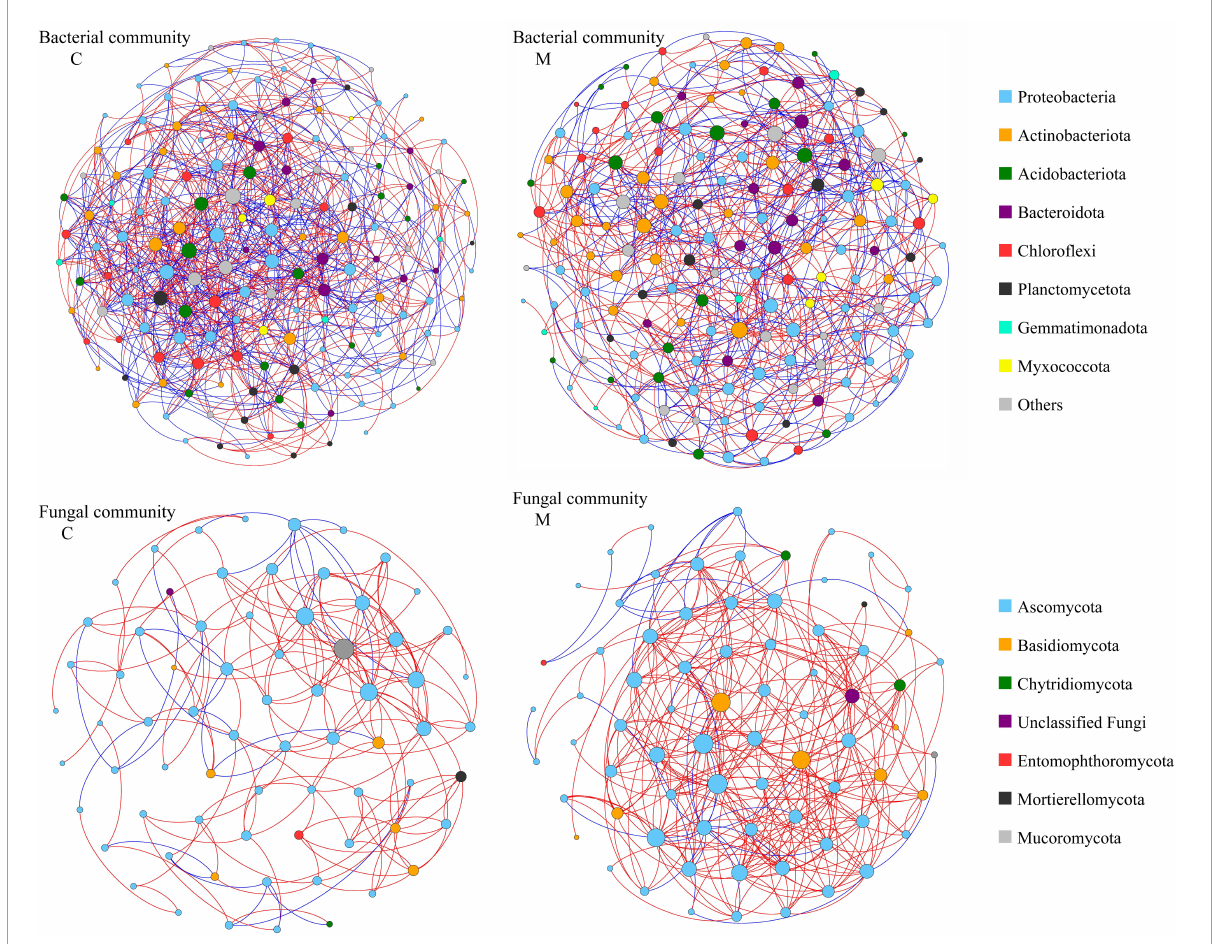
FIGURE4 Ecological networks of soil bacterial community and fungal community under different organic manure treatments. M and C indicate treatments with and without chicken manure application, respectively. Genera are represented as nodes and correlations as edges (red: copresence, blue: mutual exclusion). The node sizes are correlated to the genus degree, and node color indicates the corresponding taxonomic assignment at phylum level.